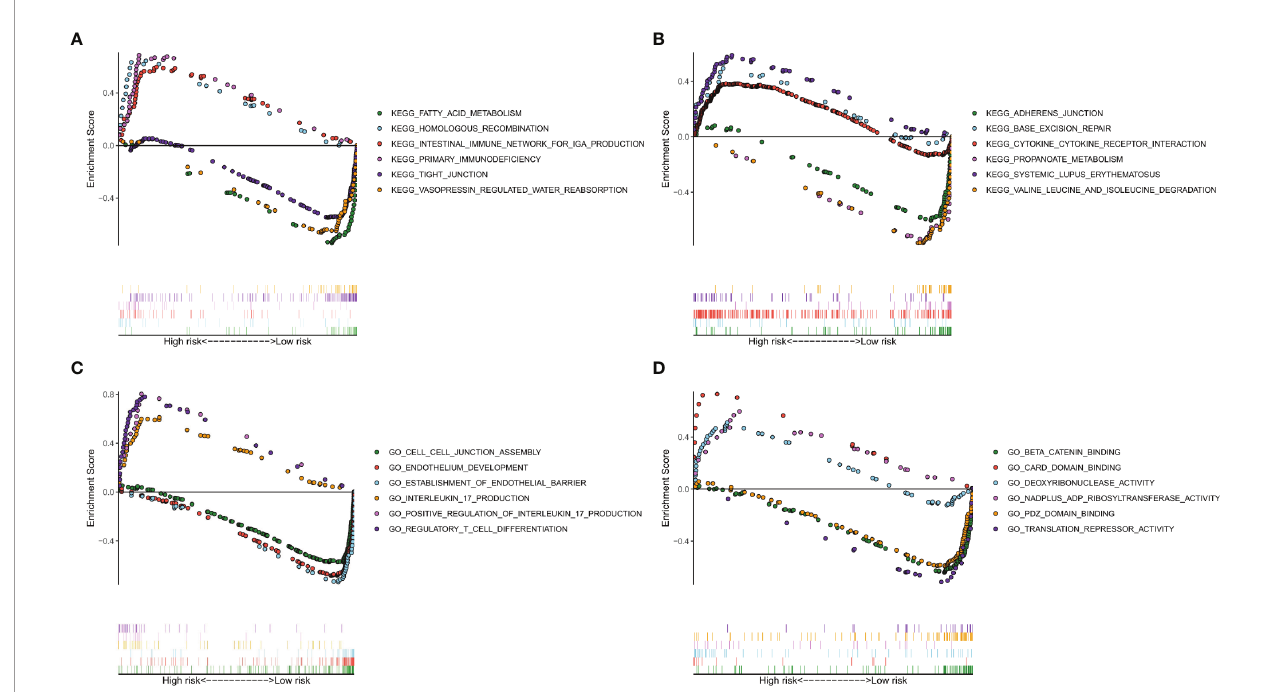
FIGURE 8 | Analysis of enriched pathways. KEGG analysis (A, B) of Gene Set Enrichment Analysis in the high- and low-risk groups in clear cell renal carcinoma. GO analysis (C, D) of Gene Set Enrichment Analysis in high- and low-risk groups in clear cell renal